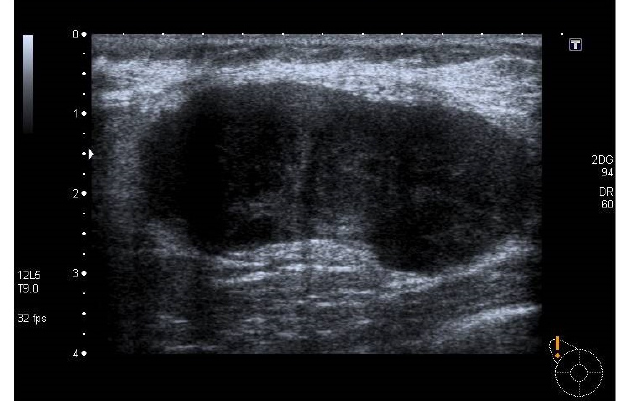
Figure 2. Ultrasound second look and fine-needle aspirate biopsy of the second